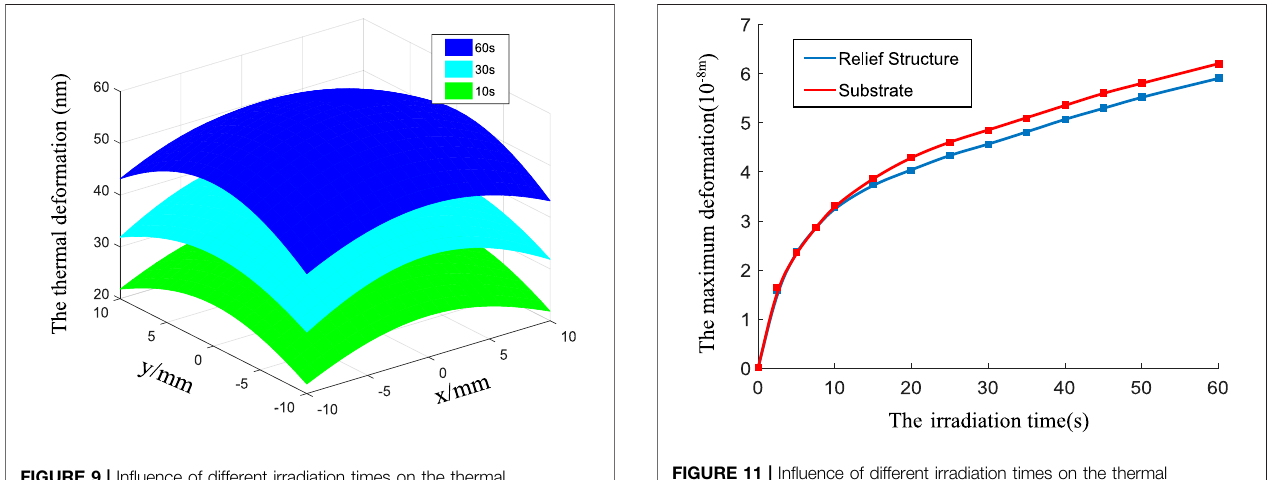
FIGURE 9 | In fl uence of different irradiation times on the thermal deformation of the relief structure.